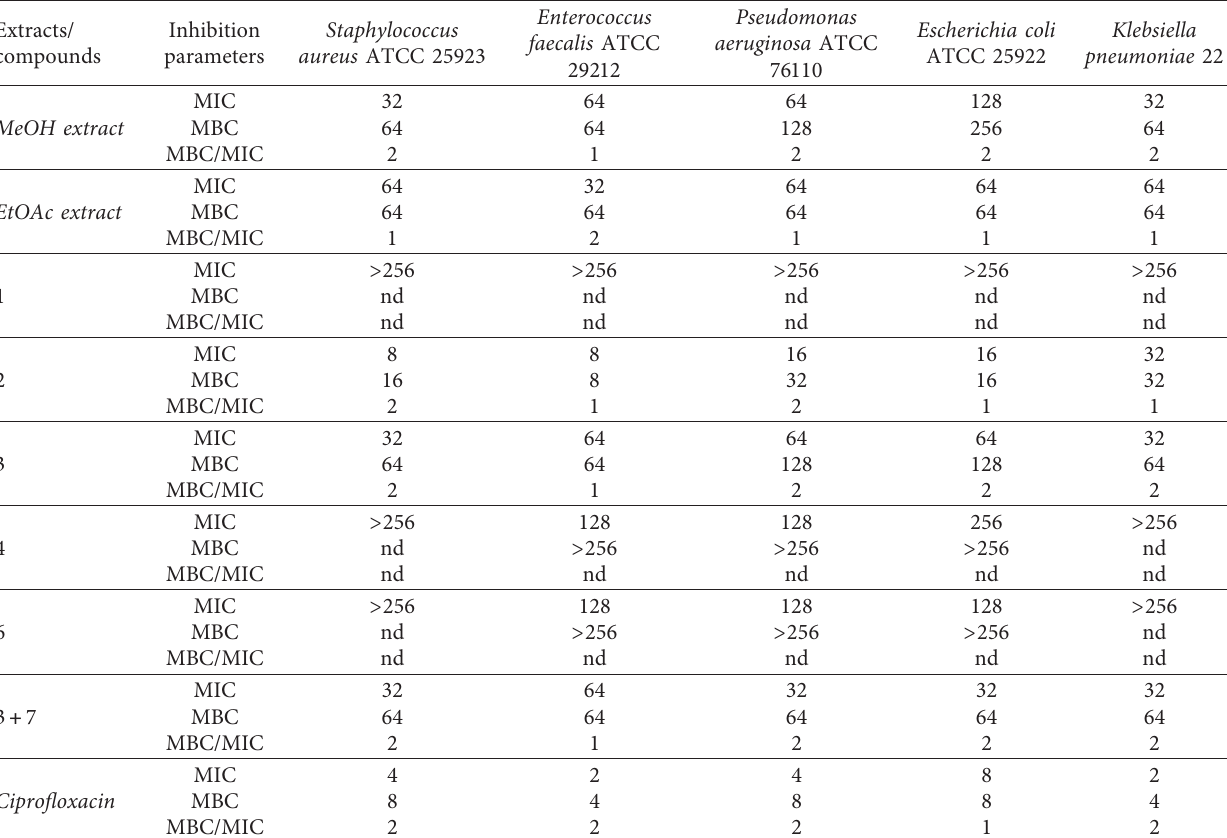
Table 1: Antibacterial activity (MIC and MBC in μ g/mL) of extracts and isolated compounds against pathogenic bacteria. Extracts/